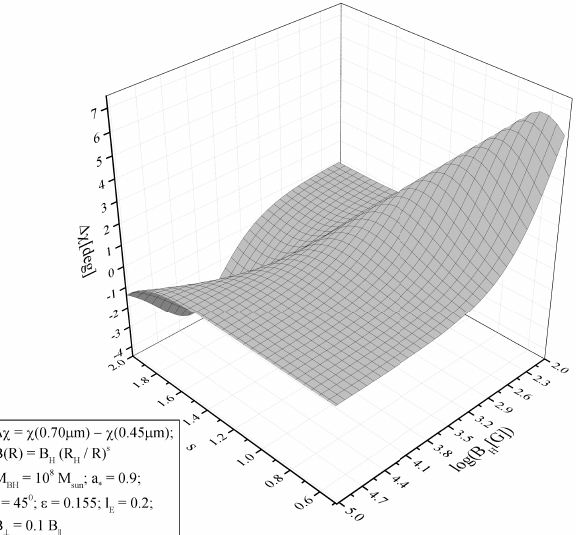
Figure 2. The difference between the positional angles of polarized radiation ∆ χ at a wavelength of 0.70 µ m and 0.45 µ m depending on the value of the magnetic field intensity at the event horizon B H and the exponent of the power-law dependence s of the magnetic field on the radius in the